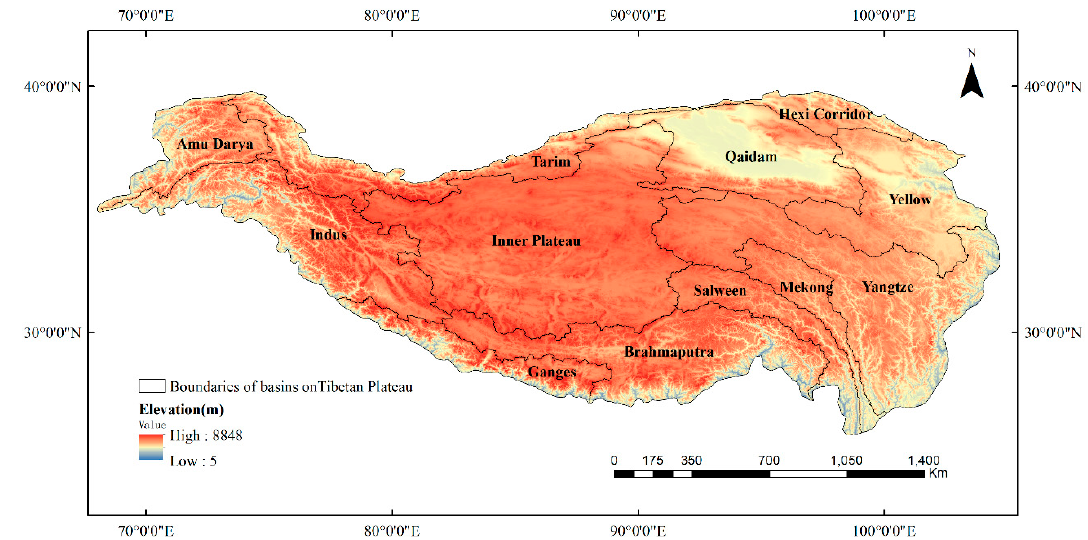
Figure 1. Study area and basin boundaries [45] .